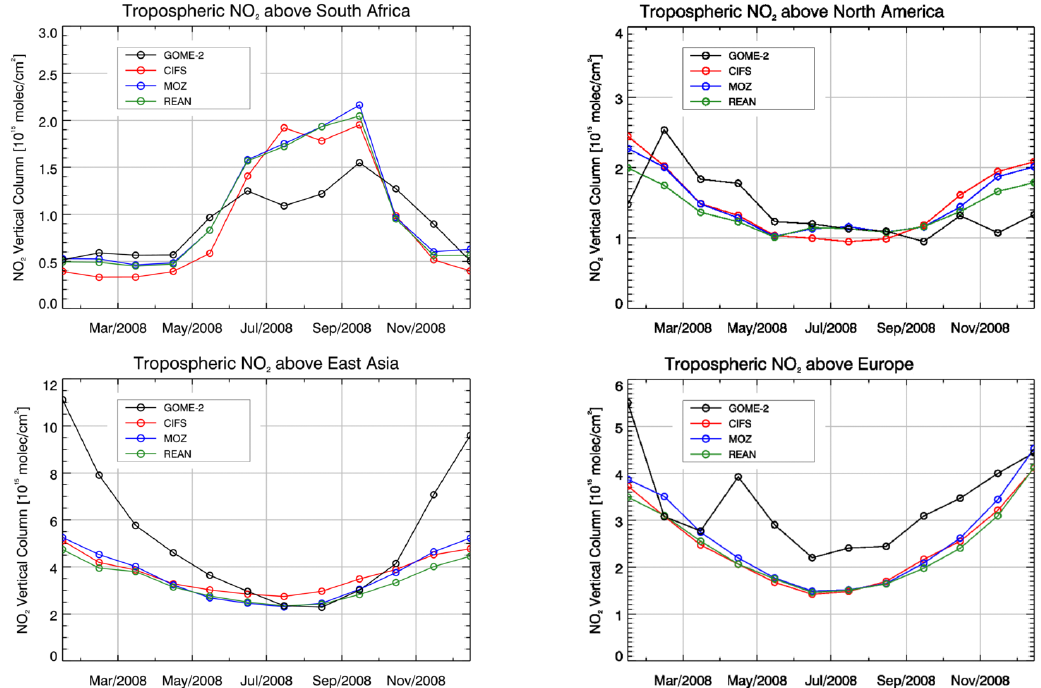
Figure 12. Time series of area-averaged tropospheric NO 2 columns (10 15 moleccm − 2 ) from GOME-2 compared to model results of C-IFS (CB05) (blue), MOZ (red) and REAN (green) for different regions.